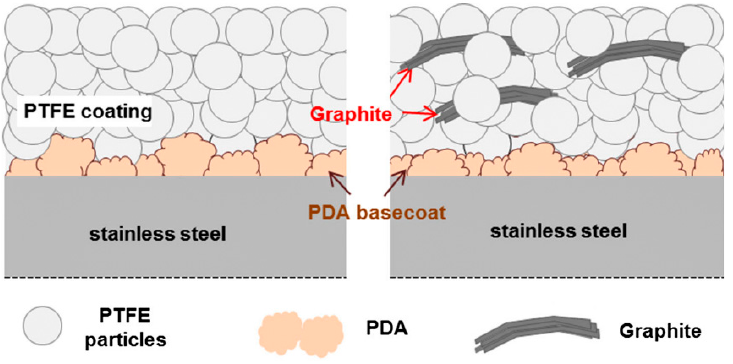
Figure 8. Schematic of PDA/PTFE and PDA/PTFE + graphite. Reprinted with permission from Ref. [49]. 2016, Springer.